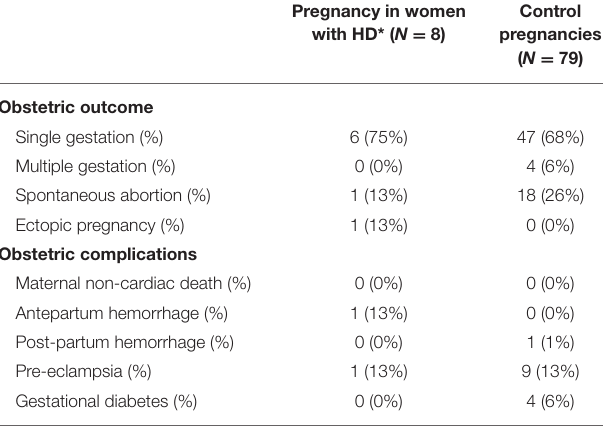
TABLE 3 | Obstetric outcomes and complications of women with HD and controls.